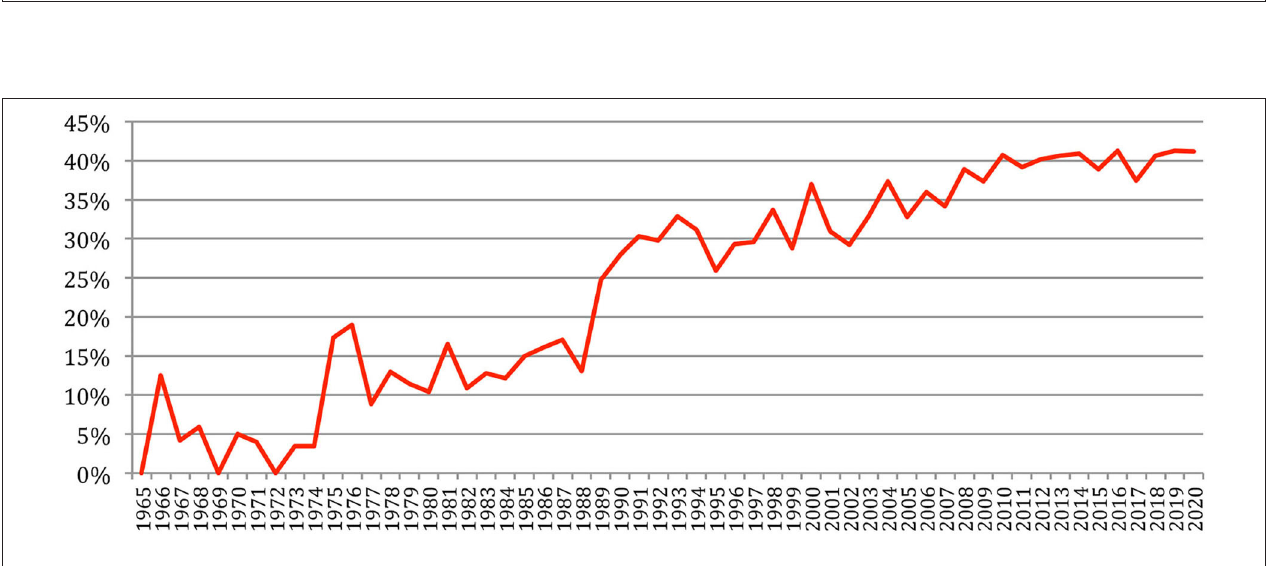
FIGURE 8 | Author redundancy over